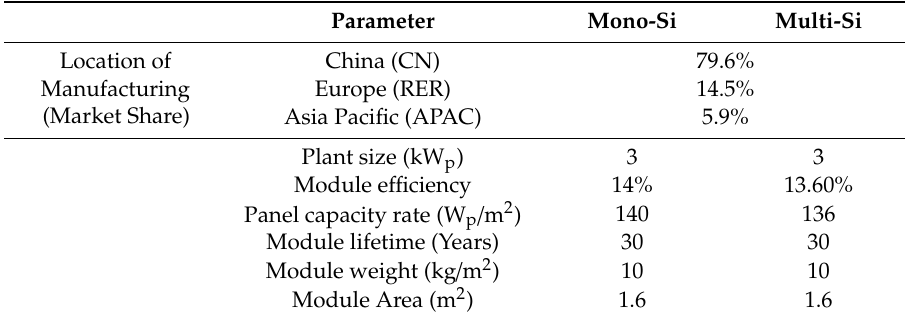
Table 1. Module modeling parameters